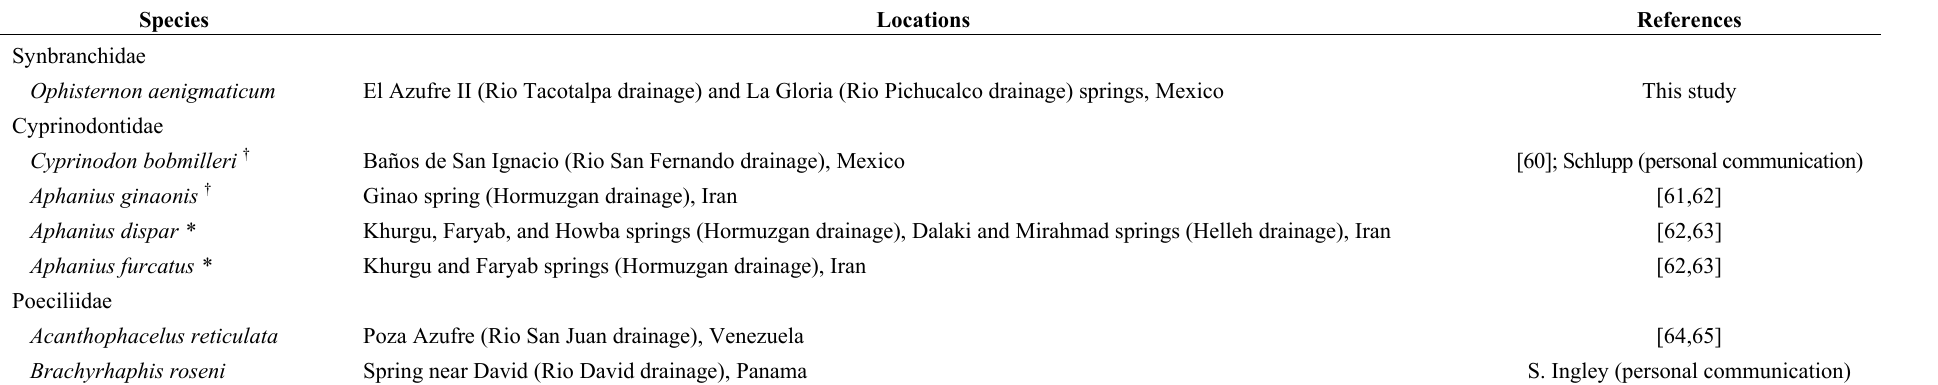
Table 1. Evolutionarily independent populations recorded from sulphide spring habitats, including specific localities and